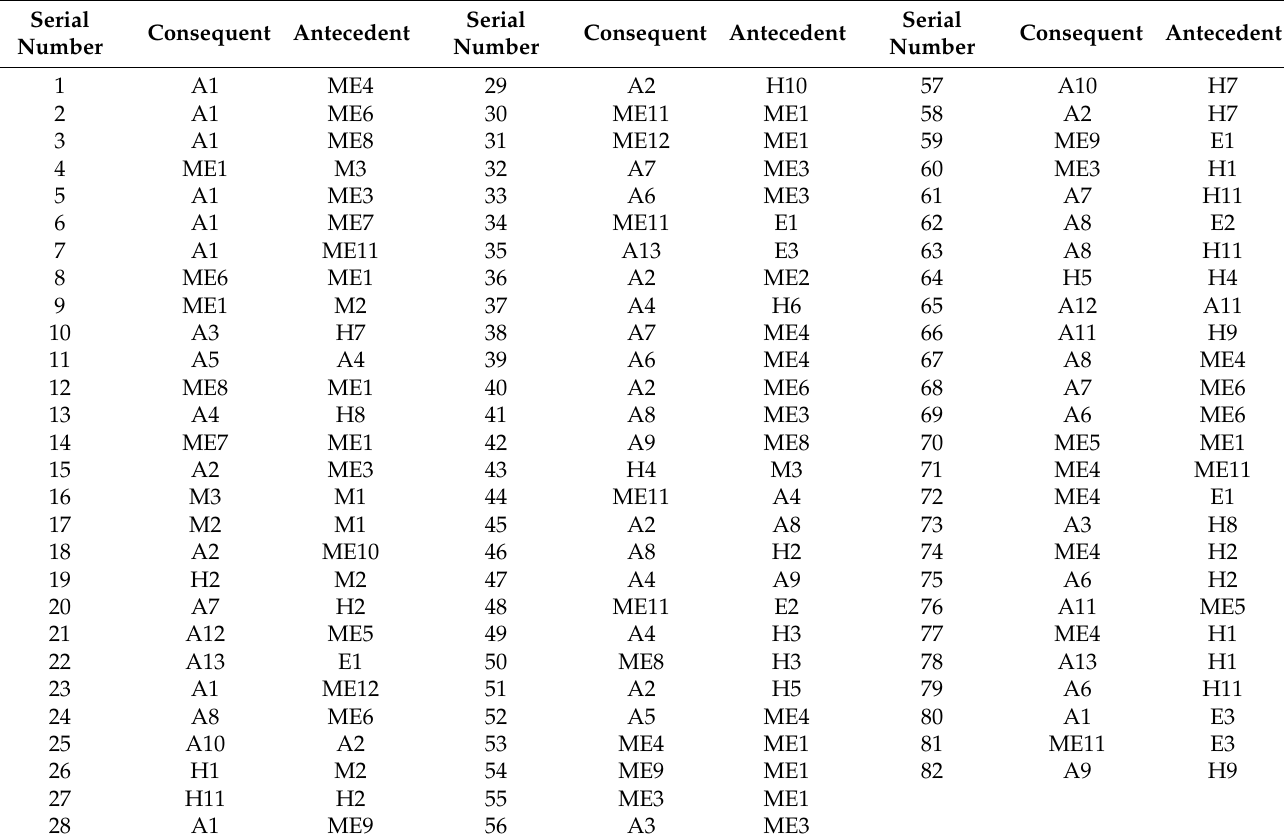
Table 4. Strong association rules between accidents and